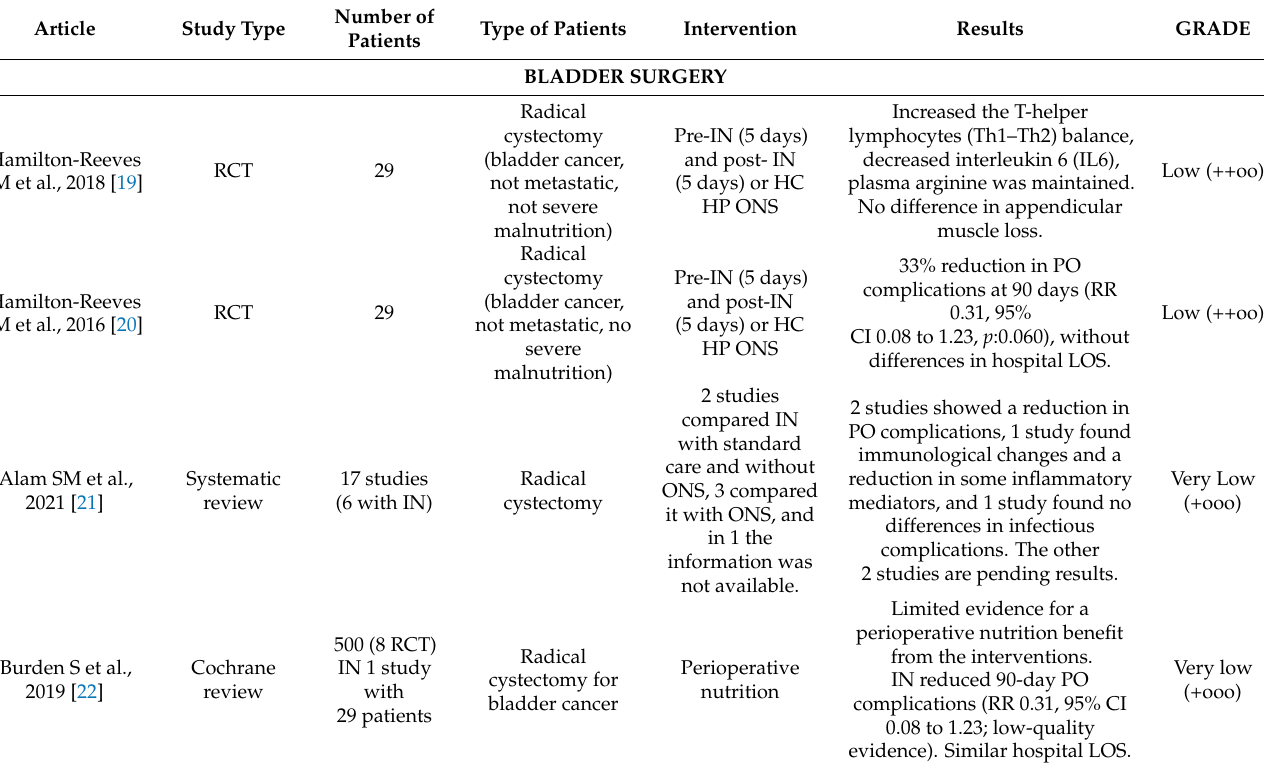
Table 5. Summary of the evidence obtained based on the search strategy and selection of articles with evidence rating using GRADEpro for bladder surgery. IN: immunonutrition; SN: standard nutrition; ONS: oral nutrition supplement; HC HP ONS: hypercaloric/hyperproteic oral nutritional supplement; PO: postoperative, UTI: urinary tract infection; LOS: length of